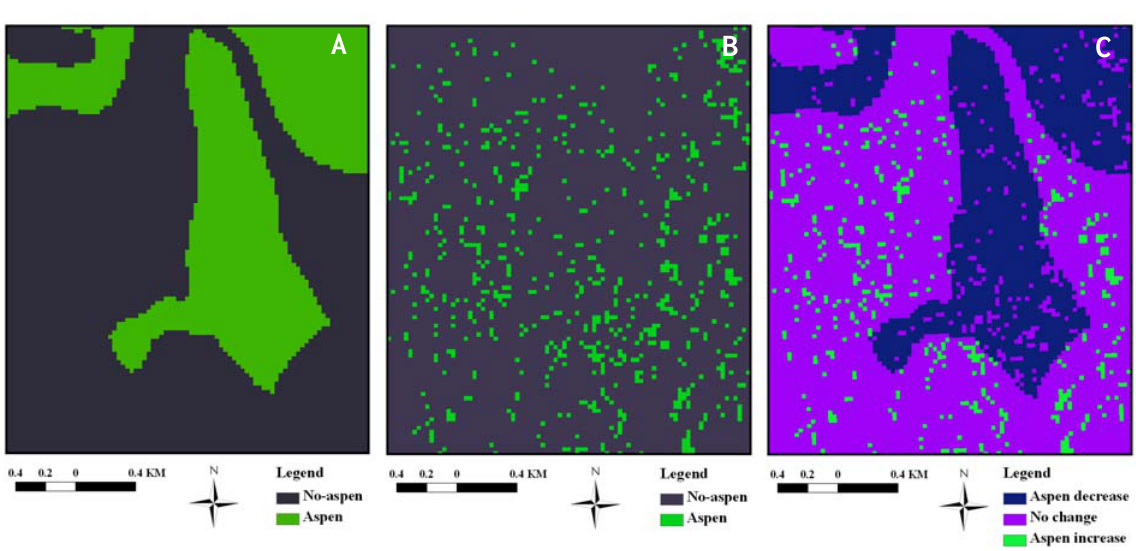
Figure 5. Examples of local-scale aspen changes between 1920 and 2005. Simple